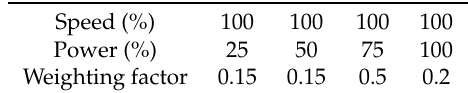
Figure 2. IMO NO x emission limits. Table 1. E-2 test cycle [18].